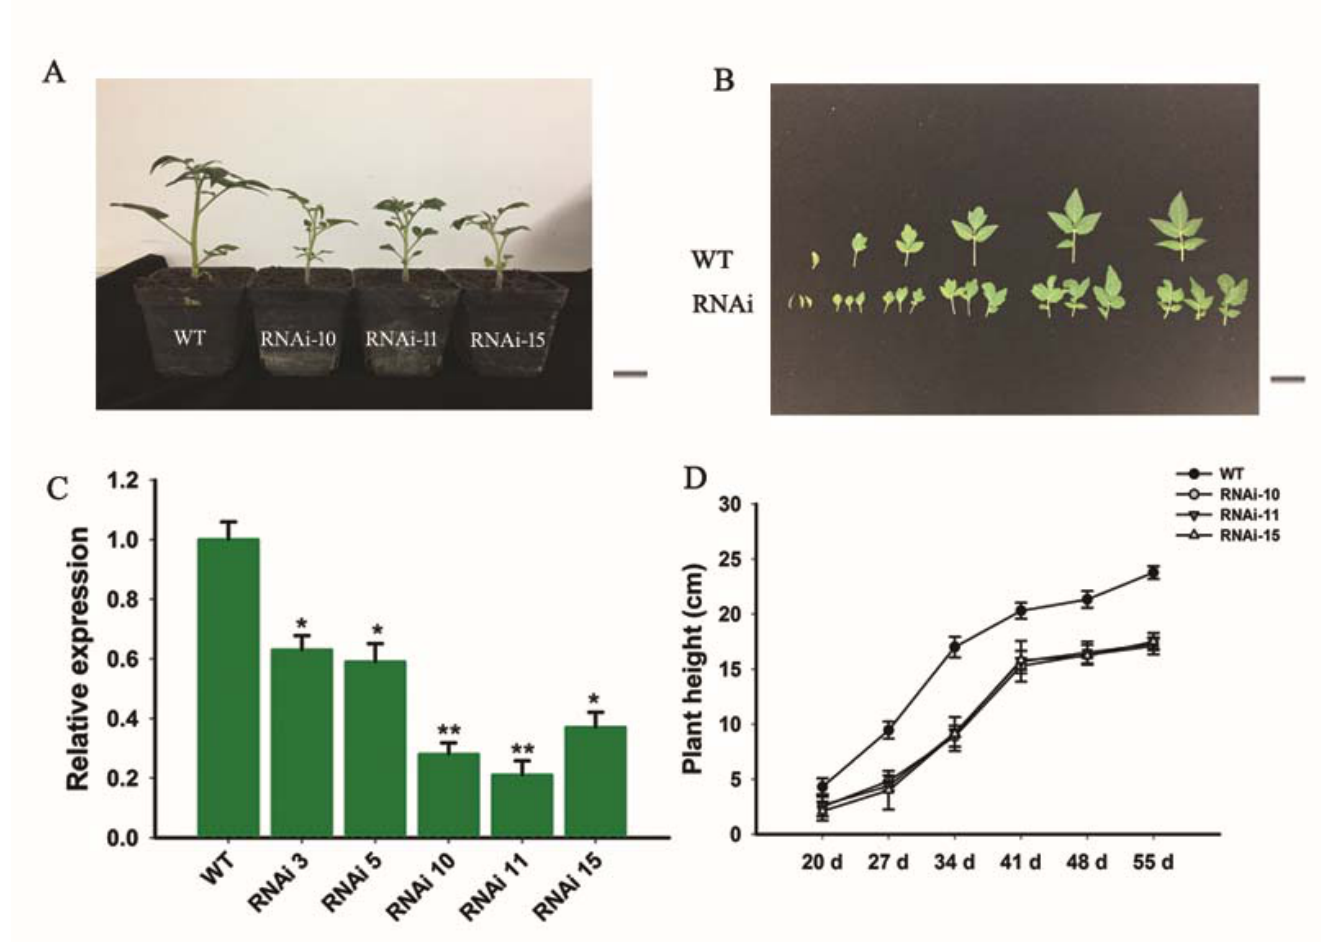
Figure 3. Morphological modifications were displayed by SlGRAS10 down-regulated transgenic lines. ( A ) The down-regulation of SlGRAS10 exhibiting decreased plant height. Photos were taken 40 days after sowing. Scale Bar = 1 mm. ( B ) Leaves of the wild-type (upper row) and the SlGRAS10 -RNAi lines (lower row). Scale Bar = 1 mm. ( C ) The expression levels of SlGRAS10 in transgenic lines and wild-type. Each value represents the mean ± SE of three independent replicates. Asterisks show the significant differences using Student’s t -test (* p < 0.05, ** p < 0.01). ( D ) The plant height of SlGRAS10 transgenic three lines and wild-type plants. The plant height was measured every week from 20-day after sowing. Each value represents the mean ± SE of three independent replicates ( n =